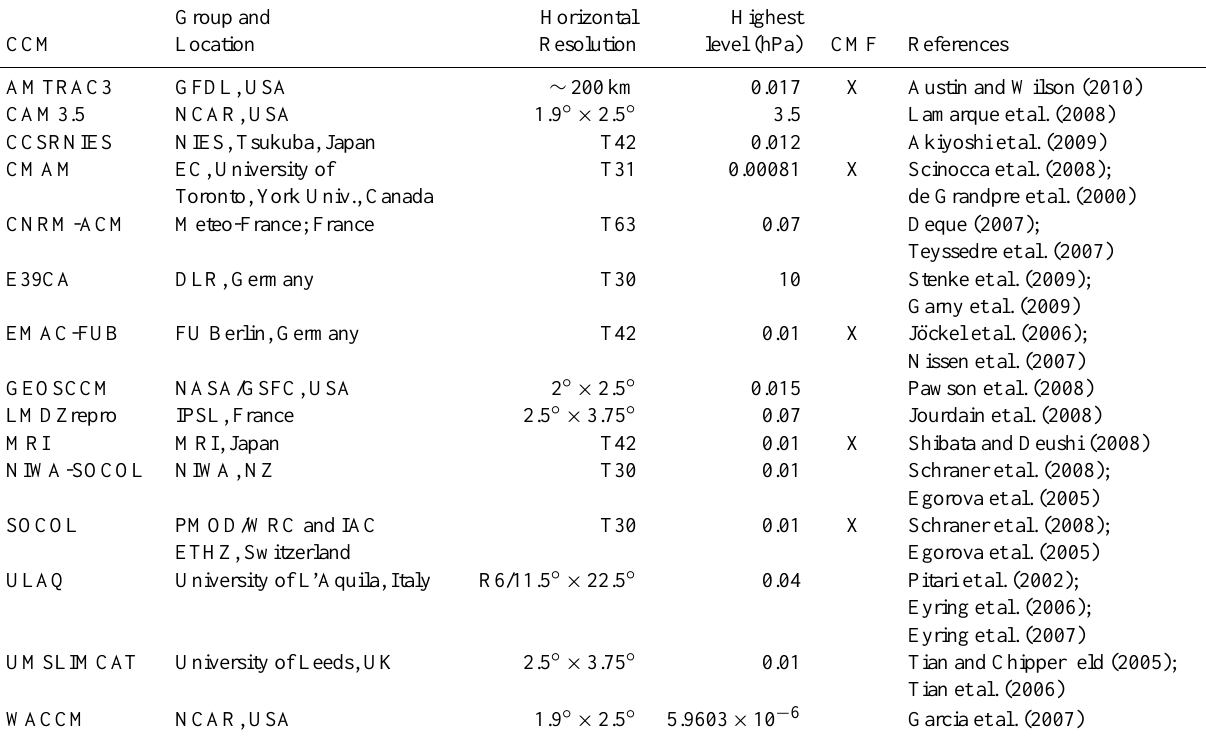
Table 1. List and basic characteristics of CCMs used in this study. All models provided total ozone, ozone profiles and temperature profiles. Models that provided total radiation under clear and all-sky conditions are checked in the CMF